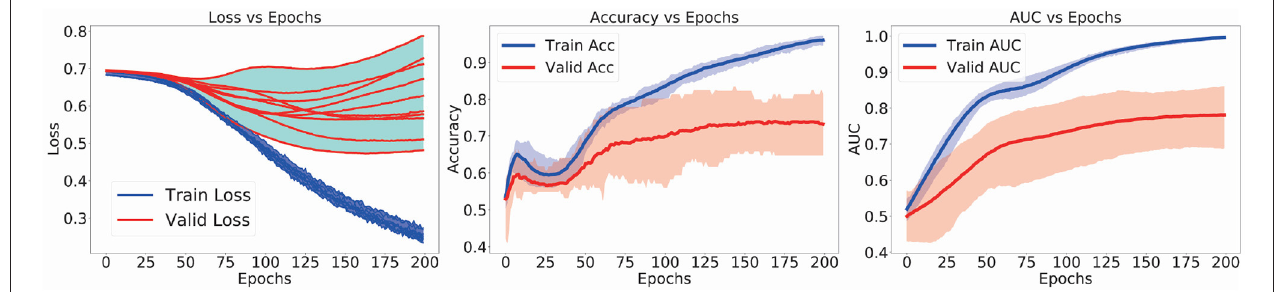
FIGURE 3 | Loss(accuracy or AUC)-vs.-epochs curves in the 10-fold cross-validation (CV) training procedure.